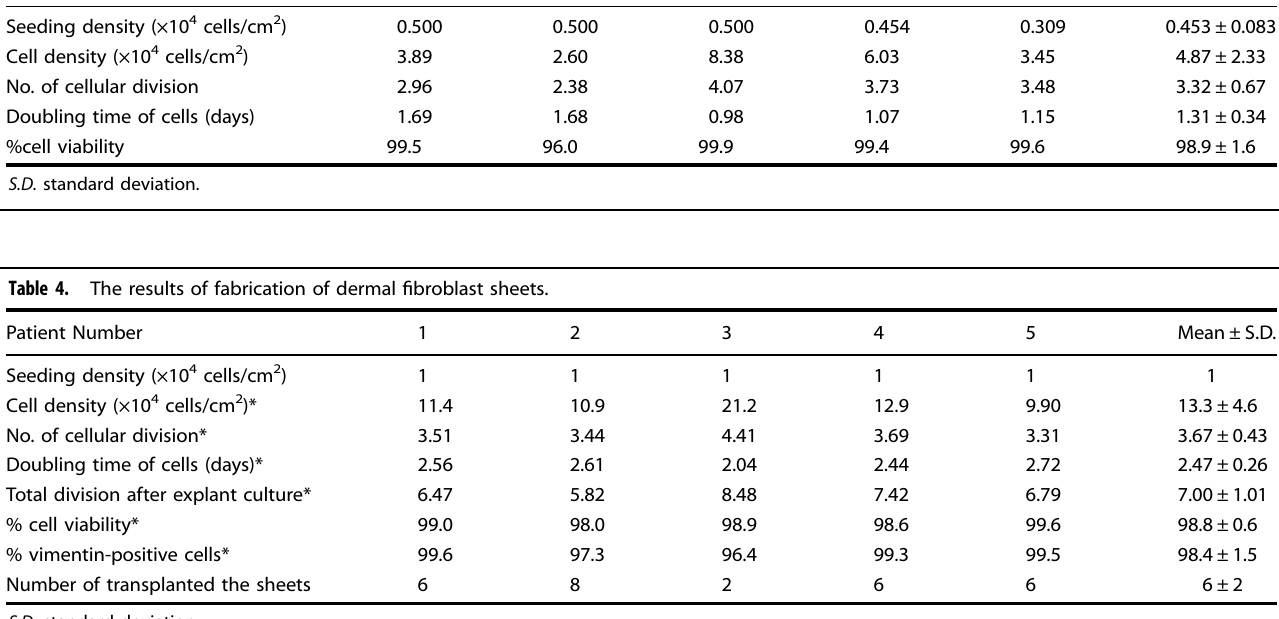
Table 3. The results of subculture.